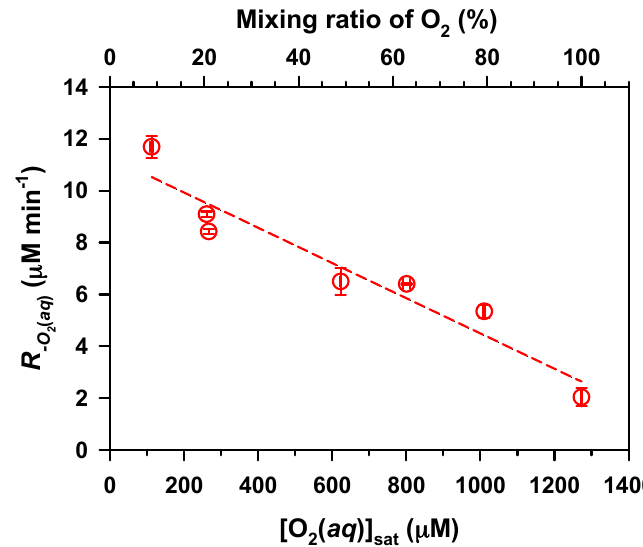
Figure 4. Rate of dissolved oxygen decay ( R − O ) vs. dissolved oxygen concentration ([O 2 ( aq )]) during irradiation ( λ ≥ 305 nm, I a = 1.02 × 10 − 5 Einstein L − 1 s − 1 ) of 20.0 mM solutions of PA at pH 1.0 and 25 ◦ C with continuous air sparging at 100.0 mL min − 1 (incomplete oxygen depleted regime). For reference, the top horizontal axis represents the mixing ratio of O 2 ( g ) dissolved in N 2 ( g ). Represented reaction rates are multiplied by − 1.